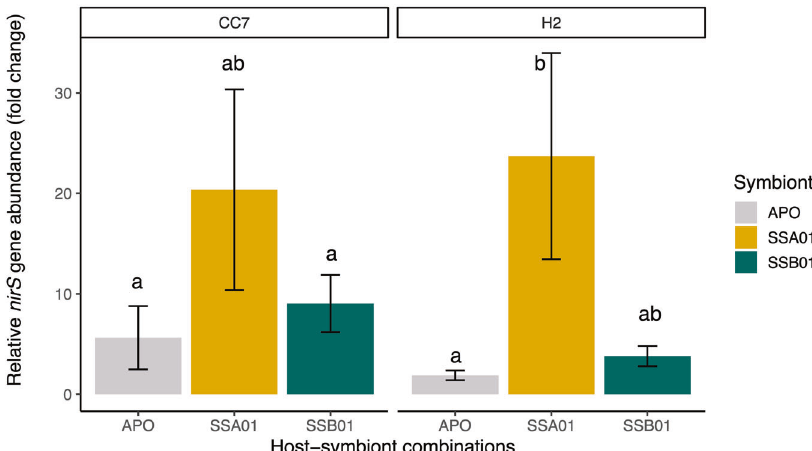
Fig. 3 Relative abundance of denitri fi ers. Relative fold change in copy numbers of the nirS gene in relation to the mean Ct of aposymbiotic CC7 samples. DNA inputs for qPCR are normalized. All data are presented as mean ± SE ( n = 5 animals each). Different letters above bars indicate signi fi cant differences between groups (Kruskal – Wallis with Dunn test, P <